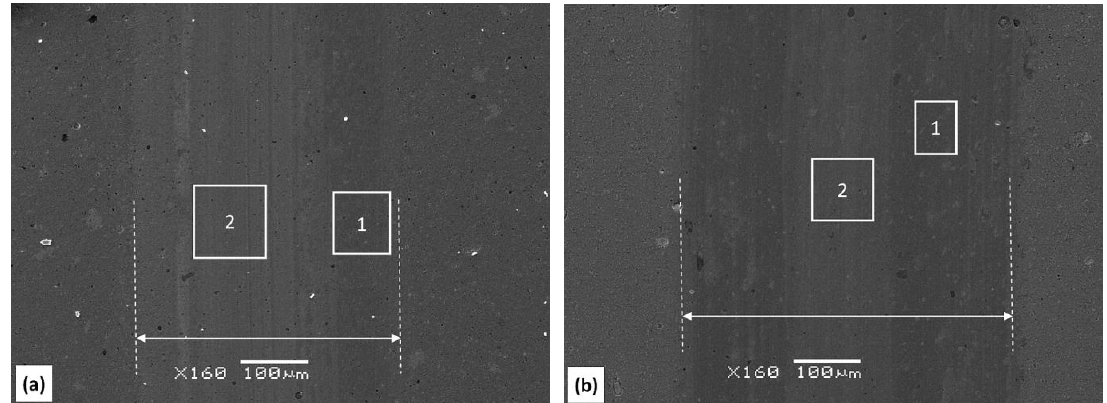
Figure 9. SEM micrographs and chemical composition from energy-dispersive X-ray spectroscopy (EDX) of the wear tracks obtained after the ball-on-disc test at AlCrSiN formed from cathodes with silicon concentrations of ( a ) 1 at% and ( b ) 10 at%. The rectangles indicate the areas of EDX analyses. The wear depth after about 29,000 revolutions, in the friction test, was about 0.22 µ m and about 0.65 µ m for AlCrSi (1)N and AlCrSi (10)N, respectively. A greater wear depth translates directly to a greater wear width. The boundaries of the wear tracks are marked with white broken vertical lines. The wear width is about 380 µ m and 500 µ m for the coatings with lower and higher silicon concentrations, respectively.